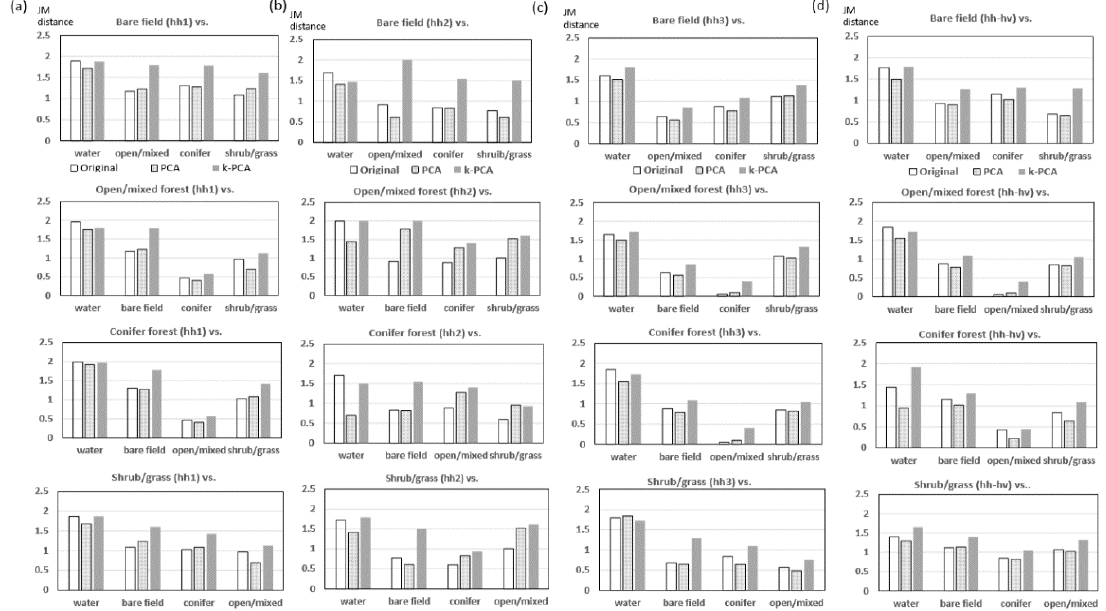
Figure 5. Land cover separabilities by Jeffreys-Matusita distances. It measured over simple phase coherence time series, PCA components (1 to 3) and k-PCA of HH1, HH2 HH3 and HH_HV packets.